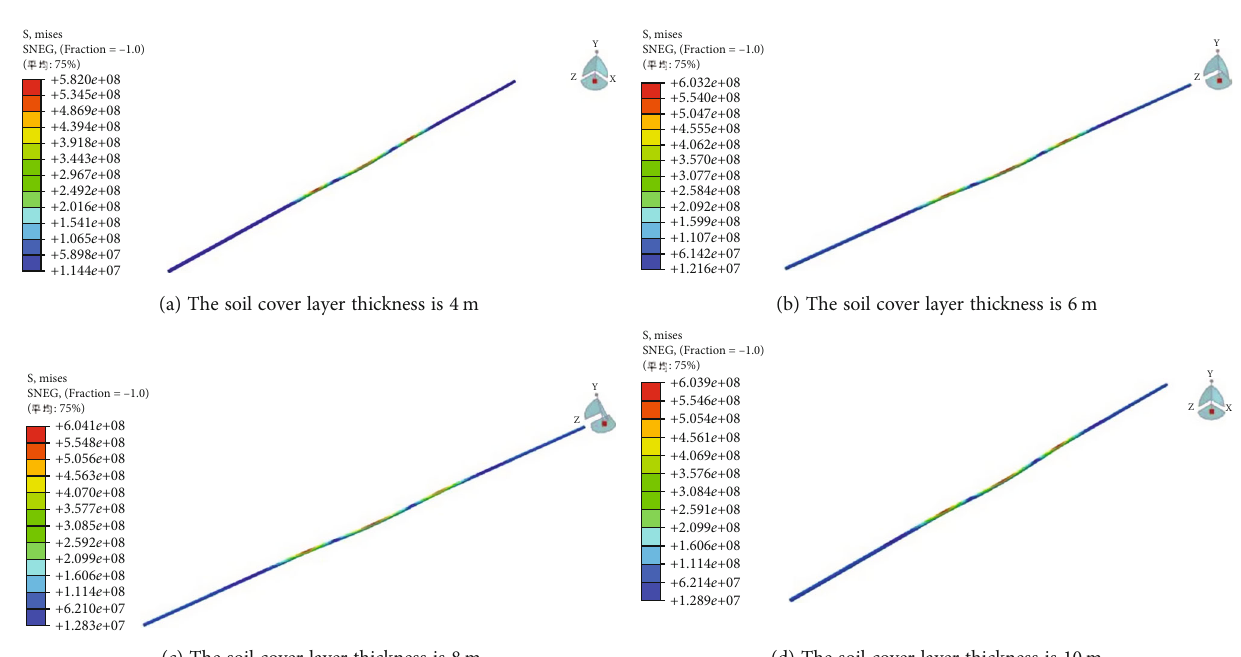
Figure 11: The pipeline stress under di ff erent cover layer